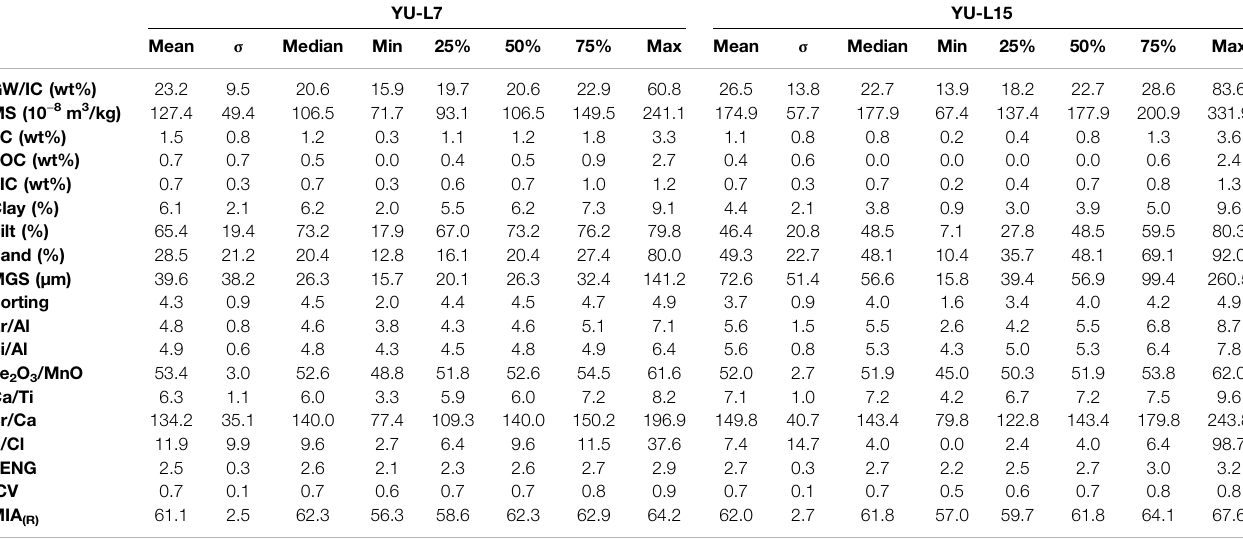
TABLE 2 | Overview of statistical characteristics for all analyzed parameters for the alas lake core YU-L7 and the Yedoma lake core YU-L15. YU-L7 YU-L15